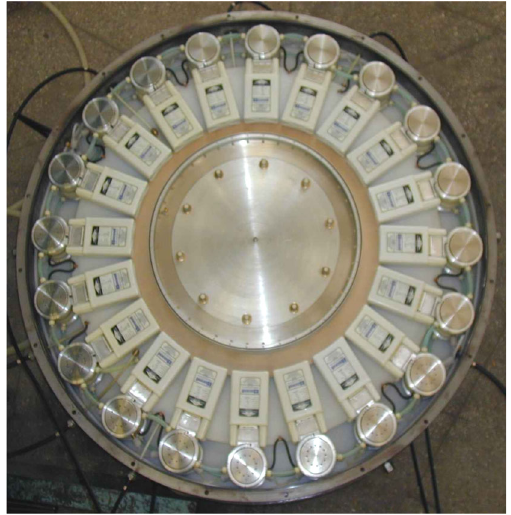
FIG. 1. (Color) Top view of the prototype LTD I cavity. The top metal cover and plastic insulator which insulates the charged parts from the cavity walls are removed.